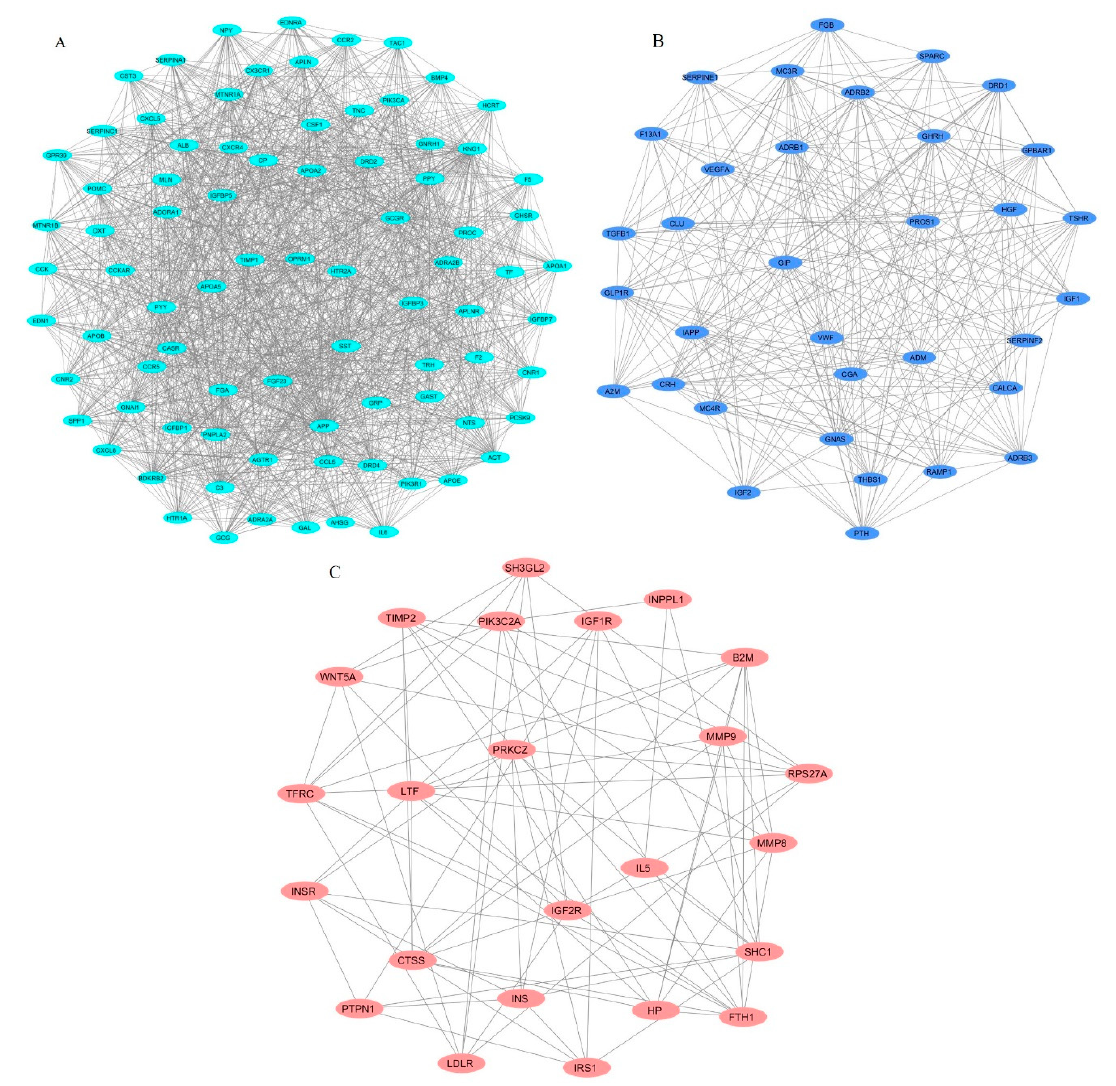
Figure 4. The top three clusters derived from the protein-protein interactions (PPI) network using MCODE. (A) Cluster 1 (score = 33.61), (B) Cluster 2 (score = 16.788), and (C) Cluster 3 (score = 6.783). Ellipse and lines represent the nodes and edges, respectively. Here, the clusters indicate direct PPIs in genes by multiple partners. Table 2. The most densely interconnected regions of the protein-protein interactions (PPI) network are categorized by MCODE from our identified associated genes between Obesity, T1D, T2D, and MODY.